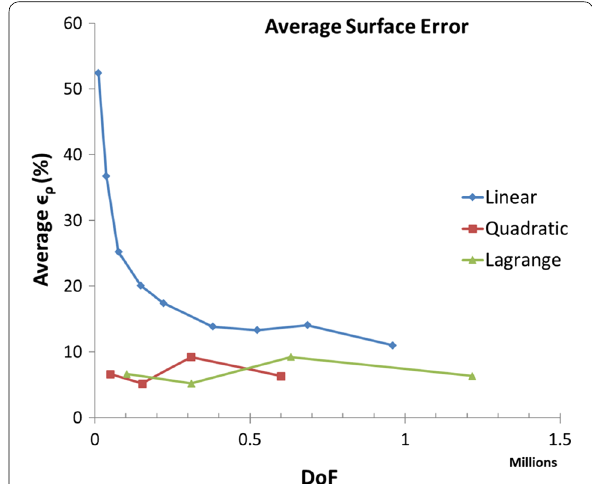
Fig. 8 Convergence with Dirichlet BC. The average surface error is shown for ρ xy as a function of the number of unknowns (DoF), which relates to the size of the